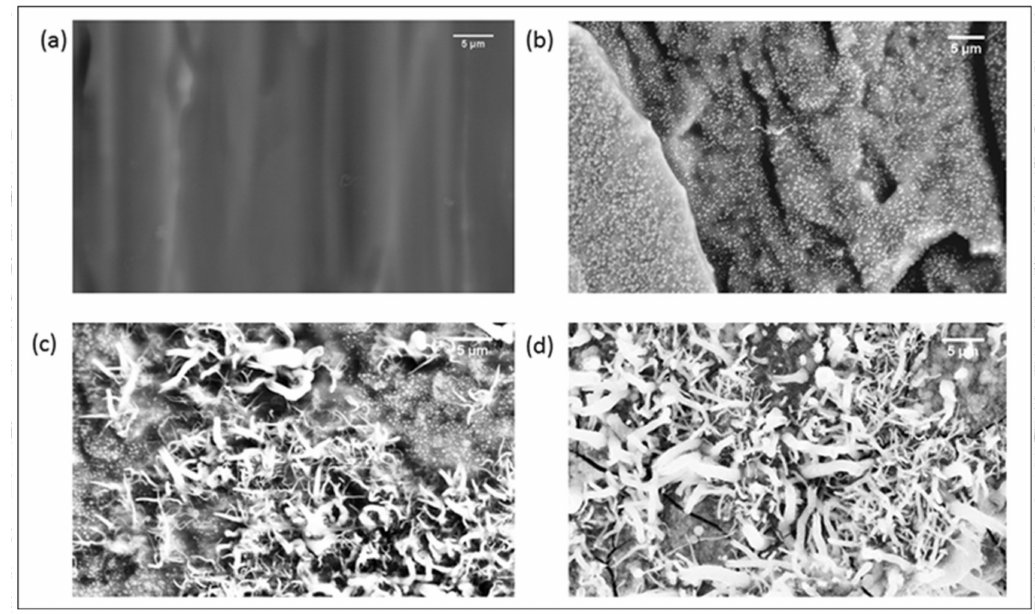
Figure 3. SEM images at 5 k magnification of ( a ) SEBS ( b ) SEBS-10PS ( c ) SEBS-30PS and ( d ) SEBS-50PS specimens cryo-fractured perpendicular to the direction of extrusion.